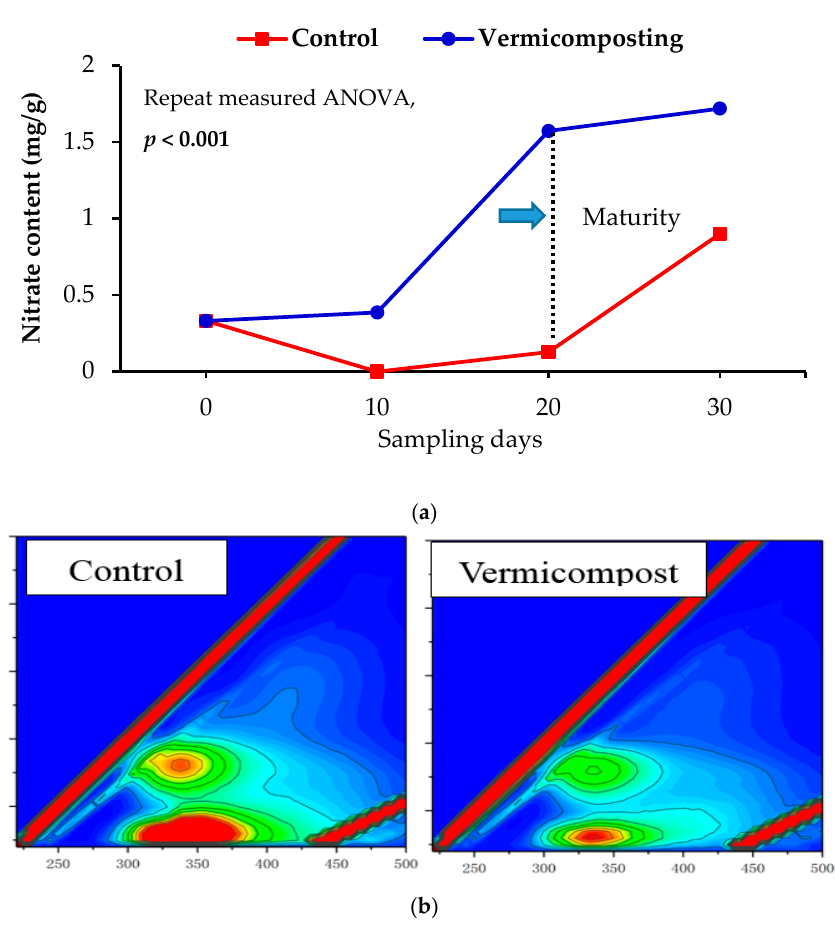
Figure 1. Changes in nitrate content ( a ) and dissolved organic carbon; ( b ) detected by 3D-EEM in vermicompost and control.